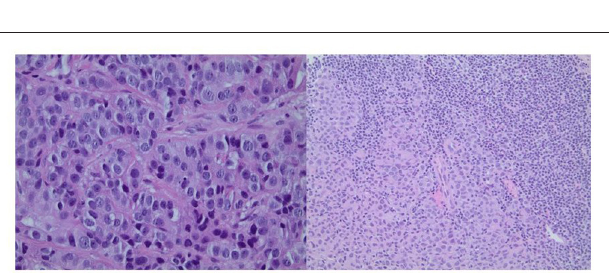
FIGURE 4 | Left panel: Core biopsy section from the left-breast mass shows invasive ductal carcinoma ( × 400 magnification). Right panel: Core biopsy section from the left infraclavicular lymph node shows metastatic breast carcinoma cells in the lymphoid tissue ( × 200 magnification).